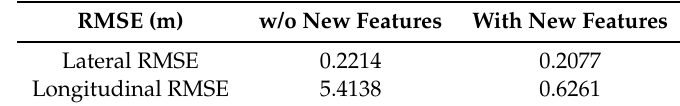
Table 3. RMSE of localization Errors from Figure 12.